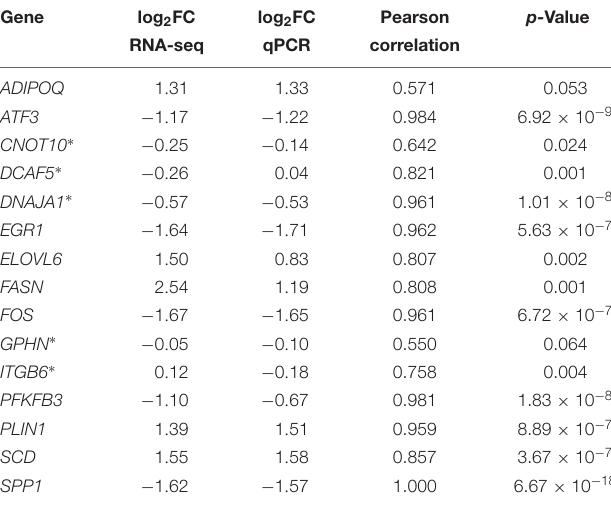
TABLE 2 | Technical validation of RNA-seq experiment by qPCR: list of validated genes, log 2 of fold change values (log 2 FC) between high (H) and low (L) groups and Pearson correlations between expression values obtained from each